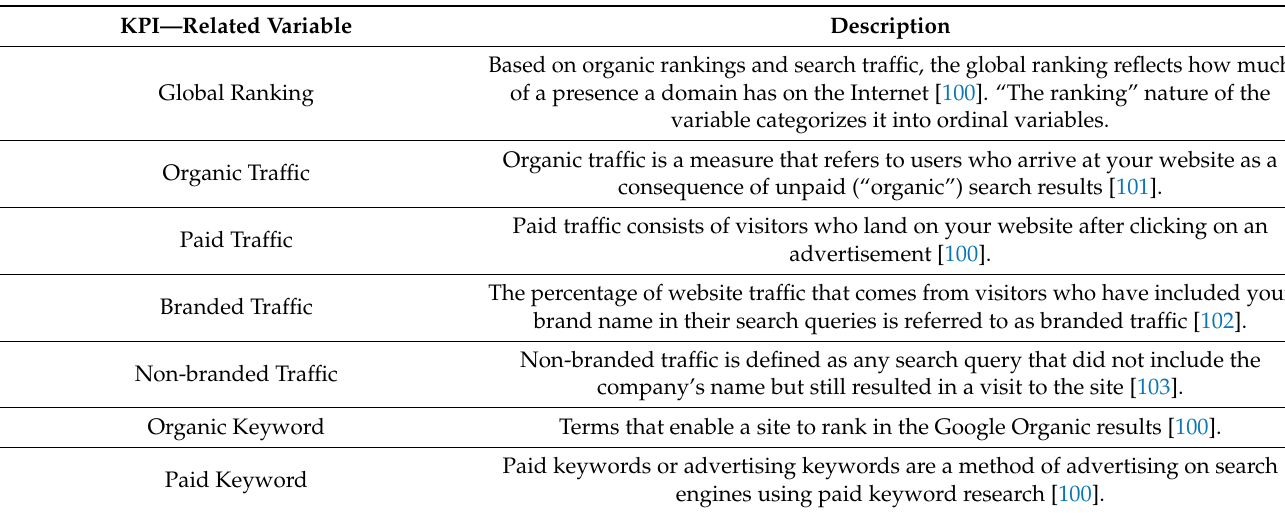
Table 1. Description of the KPIs that formed the dependent variables of the